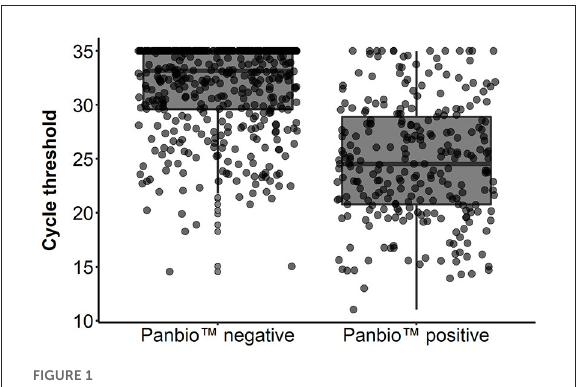
FIGURE1 Cycle threshold values in Panbio negative and positive individuals (attached).